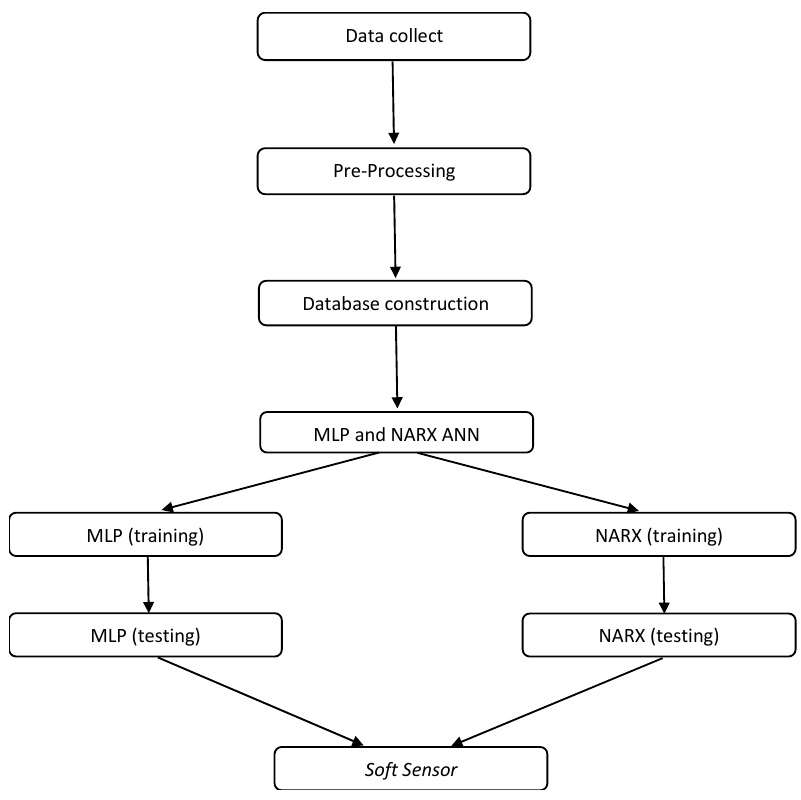
Figure 10. Flowchart for obtaining of the soft sensor.